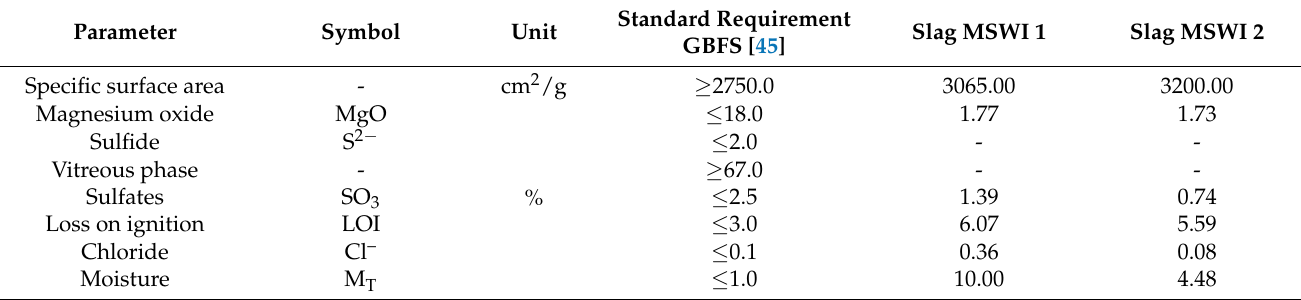
Table 7. Requirements to be met by ground granulated blast furnace slag as a cement